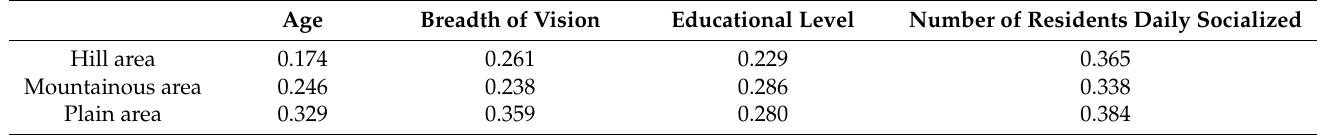
Table 12. Cramer’s V value of the correlation between residents’ leisure space preference and individual characteristics in three topographic